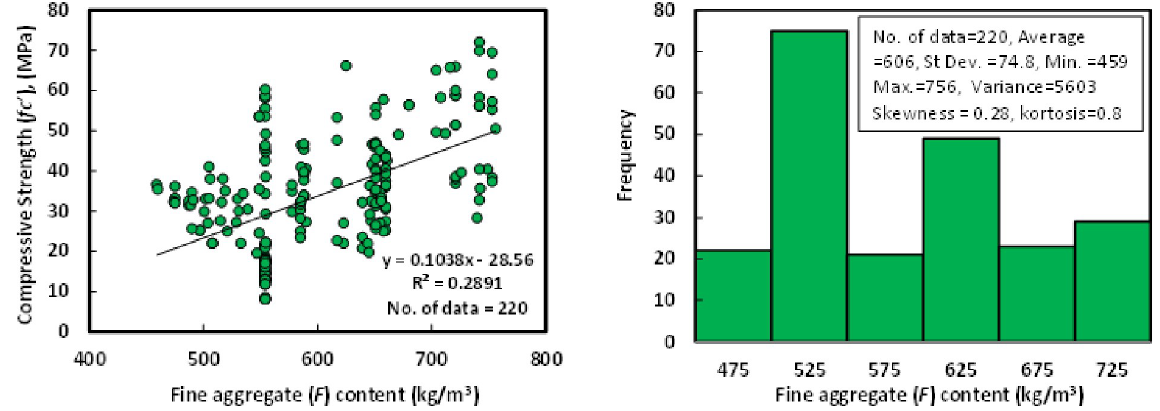
Fig 7. Relationship and a histogram of compression strength versus fine aggregate content of GGBS/FA-GPC.